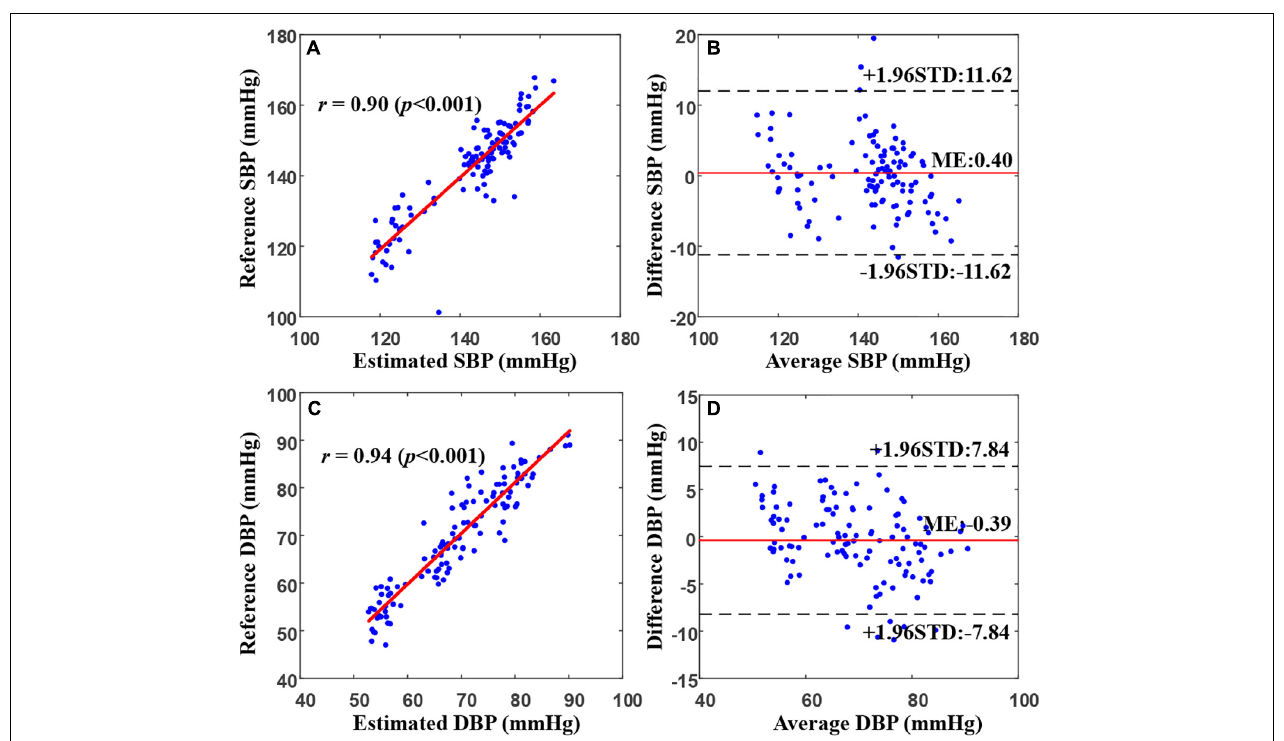
FIGURE 5 | Correlation and Bland–Altman plots for estimated SBP (A,B) and DBP (C,D) values from the proposed model (by using the random forest regression model) versus the references in a representative patient. In (B) and (D) , the black dotted and solid red lines represent the ME ± 1.96 × STD. DBP, diastolic blood pressure; ME, mean error; STD, standard deviation of error; SBP, systolic blood pressure.